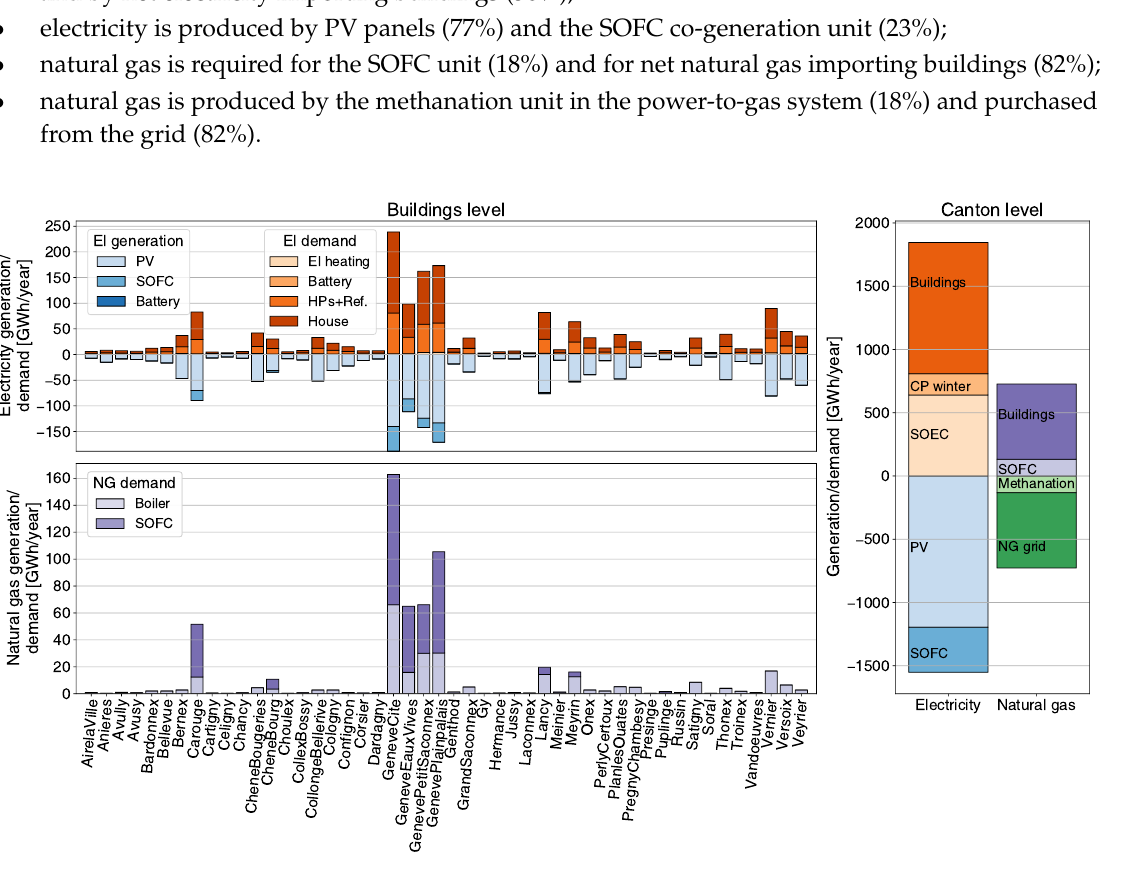
Figure 18. Breakdown of electricity/natural gas import/export by commune and at building/canton